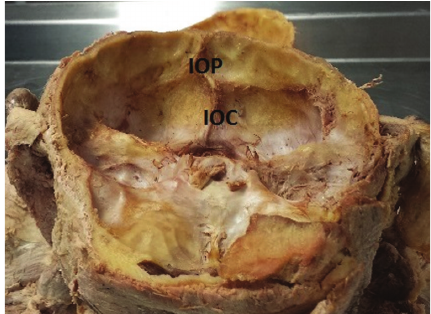
Figure 3: Enlarged view of internal occipital protuberance and internal occipital crest showing the misalignment of internal occip- ital crest (IOC) and internal occipital protuberance (IOP).